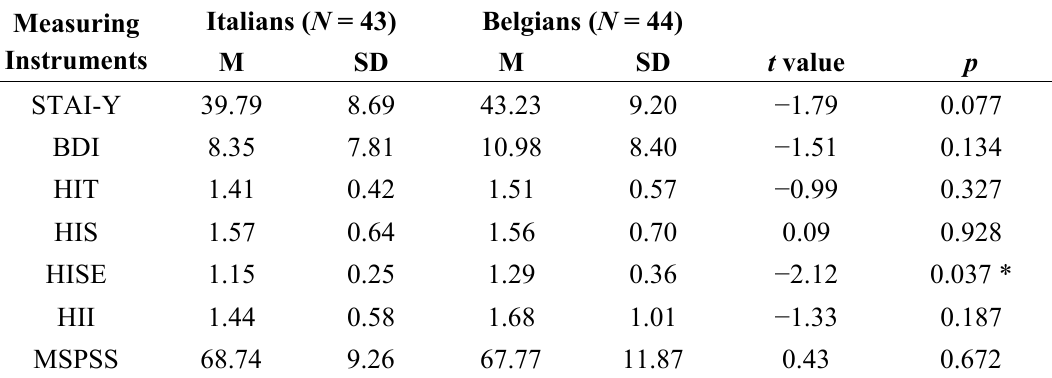
Table 4. Mean, standard deviation, t value and p value comparing Italian and Belgian lesbian’s groups.